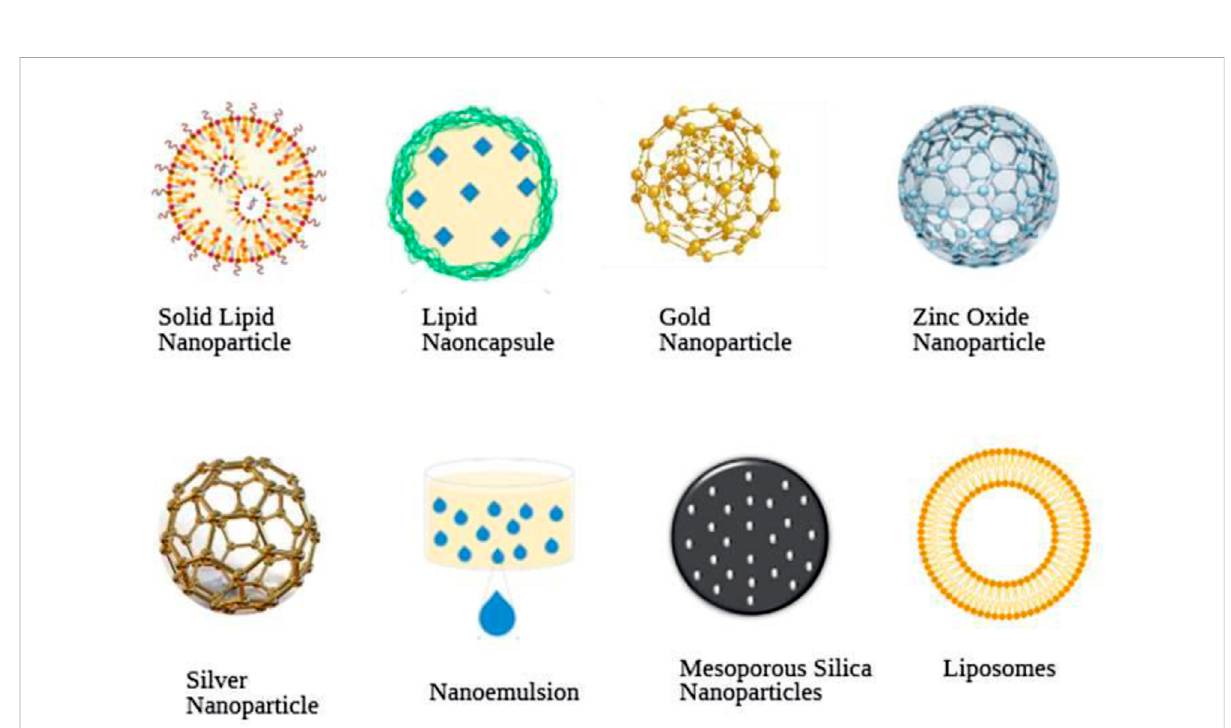
FIGURE 2 Schematic diagram of various commonly used nanoparticles in schistosomiasis treatment, diagnosis, and prevention.